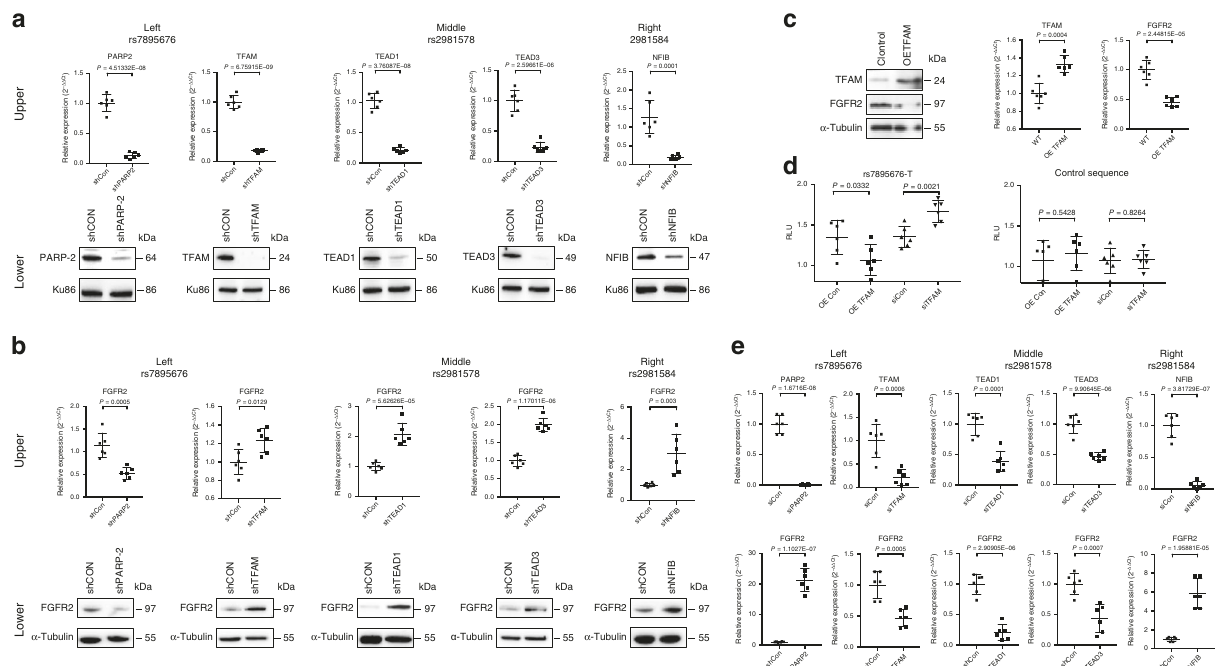
Fig. 5 Regulation of FGFR2 transcription by PARP-2 and TFAM, TEAD1 and TEAD3, and NFIB. a shRNA (sh) knockdown of PARP-2 and TFAM, TEAD1 and TEAD3, and NFIB, in MDA-MB-468 cells. Upper: result from qPCR ( n = 3 biological independent experiments with each in duplicate); Lower: results from Western blot ( n = 3 biological independent experiments). Ku86: employed as a loading control for nuclear extracts. b Modulation of FGFR2 expression in the MDA-MB-468 cells following knockdown of PARP-2 and TFAM, TEAD1 and TEAD3, and NFIB. Upper: results from qPCR ( n = 3 biological independent experiments with each in duplicate); Lower: results from Western blots ( n = 3 biological independent experiments). α -Tubulin: a loading control for cytosolic proteins. c Overexpression of TFAM downregulates FGFR2 expression as shown by Western blot (left) ( n = 3 biological independent experiments) and qPCR (right) ( n = 3 biological independent experiments with each in duplicate). OE overexpression. d Luciferase reporter assays demonstrating TFAM regulates luciferase activities through rs7895676(T) evidenced by either overexpression (OE) or siRNA (si) knockdown in MDA- MB-468 cells. The data represent six biological independent samples ( n = 6). e FGFR2 expression following siRNA (si) knockdown of PARP-2 and TFAM (left), TEAD1 and TEAD3 (middle), and NFIB (right) in MCF7 cells. The data from Western blots represent three biological independent experiments ( n = 3) and the data from qPCR represent three biological independent experiments with each in duplicate ( n = 3). P value was calculated using Student ’ s t test with two tails. Error bars in all the plots represent the median with SE. Source data are available in the Source Data fi